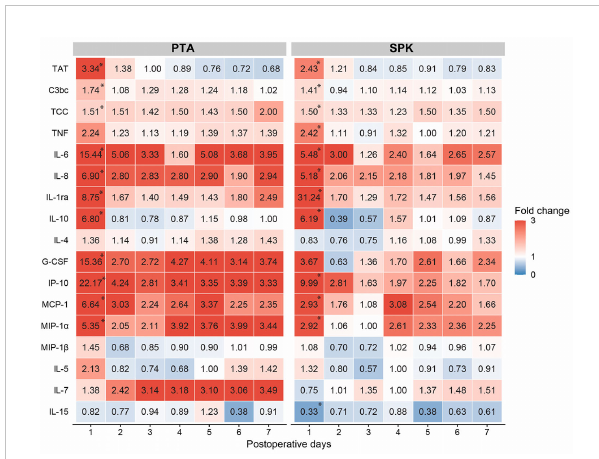
FIGURE 3 Median fold changes of in fl ammatory markers for postoperative days 1-7 compared to preoperative values (day=0) for pancreas transplant alone (PTA) and simultaneous pancreas-kidney (SPK) recipients. The red color indicates increased fold change and the blue color decreased fold change compared to preoperative median concentration. *Indicates signi fi cantly ( p <0.05) increased fold change from preoperative values to the fi rst postoperative day (Sign test) within PTA and SPK groups. Fold changes on POD 1 and sums of fold changes POD1-7 were compared between SPK and PTA recipients (Mann Whitney U-test) and presented in Table S4. CRP, C-reactive protein; G-CSF, granulocyte colony-stimulating factor; IL, interleukin; IL-1ra; interleukin-1 receptor antagonist; IP-10, interferon gamma-induced protein 10; MCP-1, monocyte chemoattractant protein 1; MIP, macrophage in fl ammatory protein; TAT, thrombin-antithrombin complex; TCC, terminal complement complex; TNF, tumor necrosis